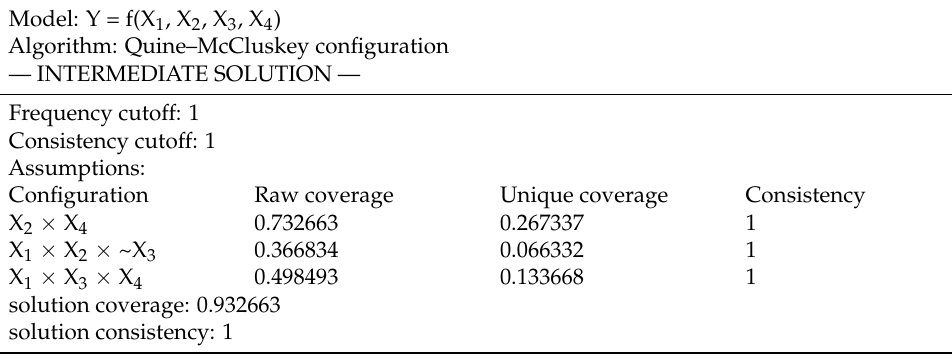
Table 6. Intermediate solution for the outcome.